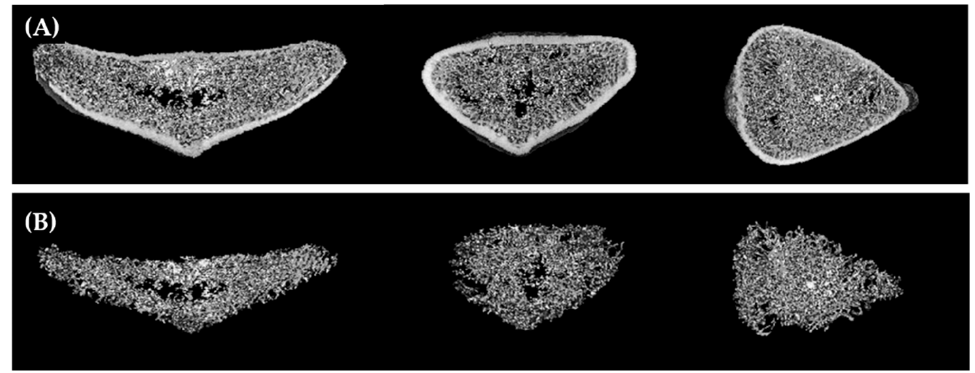
Figure 1. Micro-positron emission tomography/computed tomography images of the sternum: ( A ) total bone; ( B ) trabecular